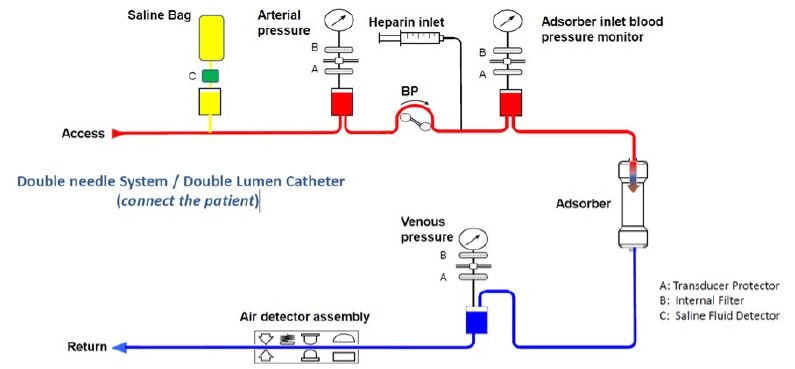
Figure 3. Schematic drawing of the extracorporeal circuit equipped with protective systems and features to help ensure patient safety and correct operation, mainly monitored by pressure (A, B), sensors, air, blood, and blood tubing line detectors. BP: blood